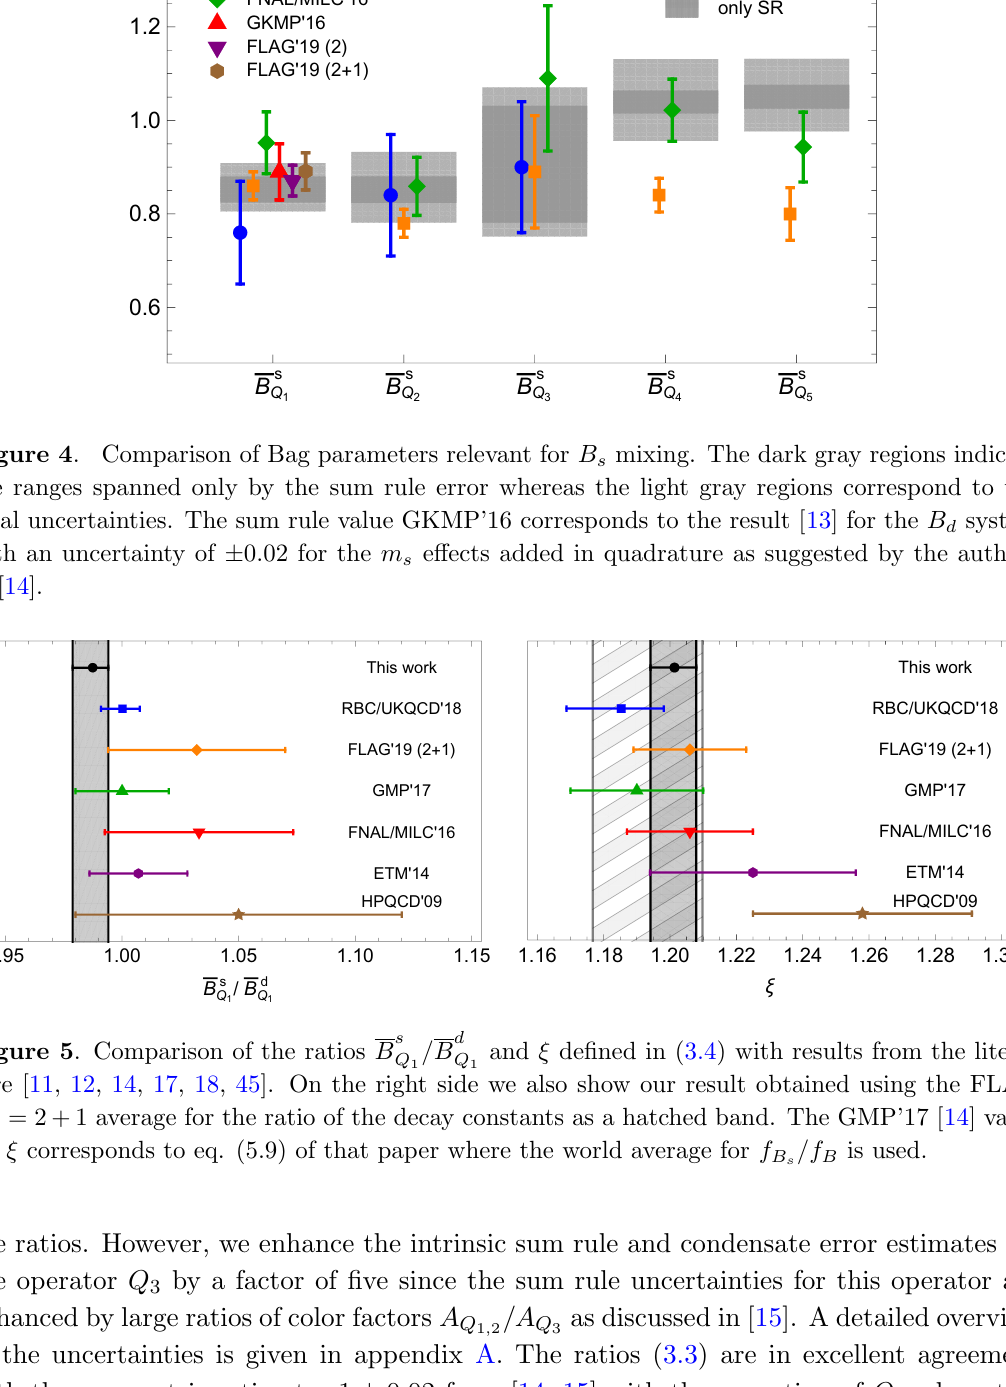
=B d and (cid:24) de(cid:12)ned in (3.4) with results from the litera- Q 1 Q 1 =f B is s